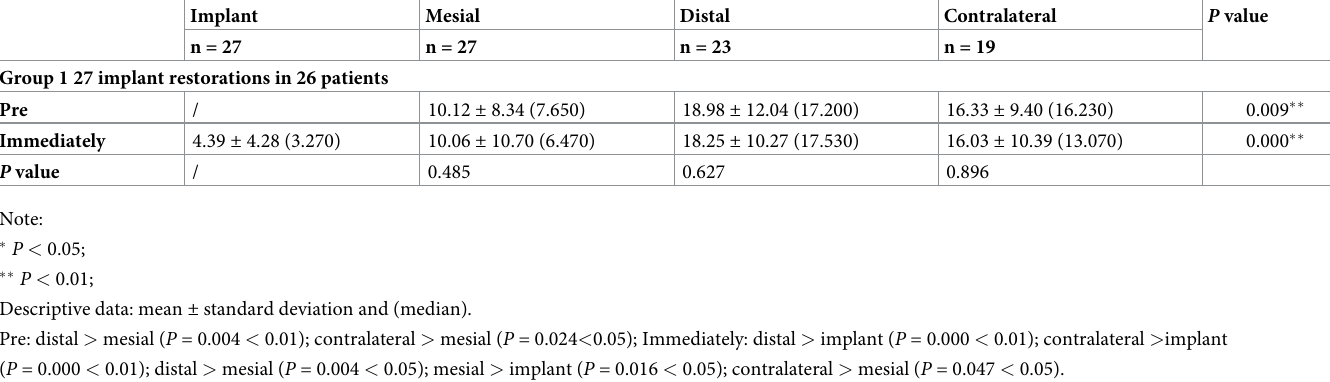
Table 3. Comparison of the bite force distributed on implants and teeth (before treatment vs immediately following restoration). Implant Mesial